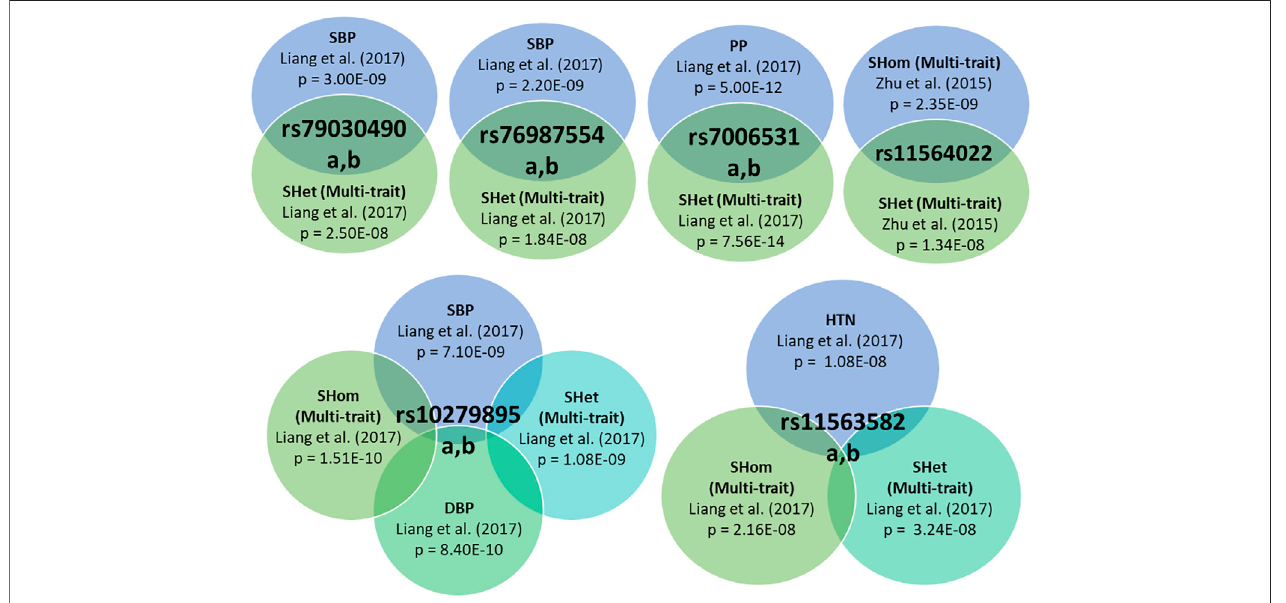
FIGURE 3 | Individual variants with associations to multiple BP-related traits, exhibiting pleiotropic effects.